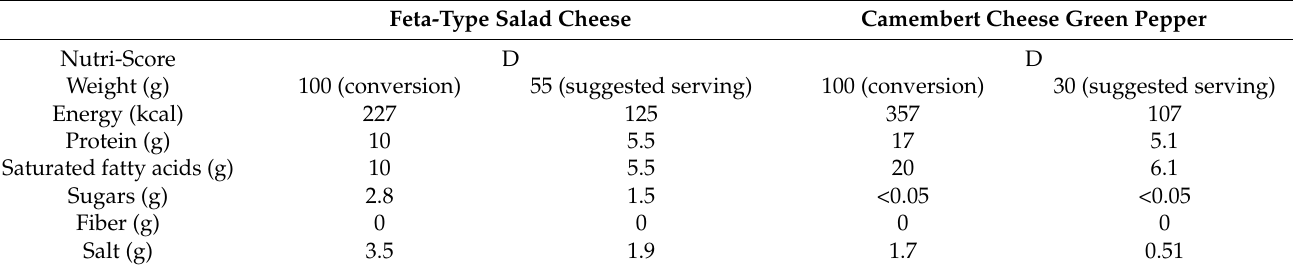
Table 2. Comparison of nutrient contents of commercially available cheeses by package size. Feta-Type Salad